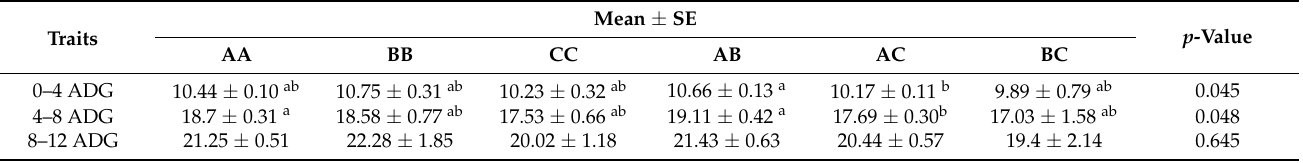
Table 1. Association analysis of the QPCTL multiallelic Indels with growth traits in the Gushi x Anka F2